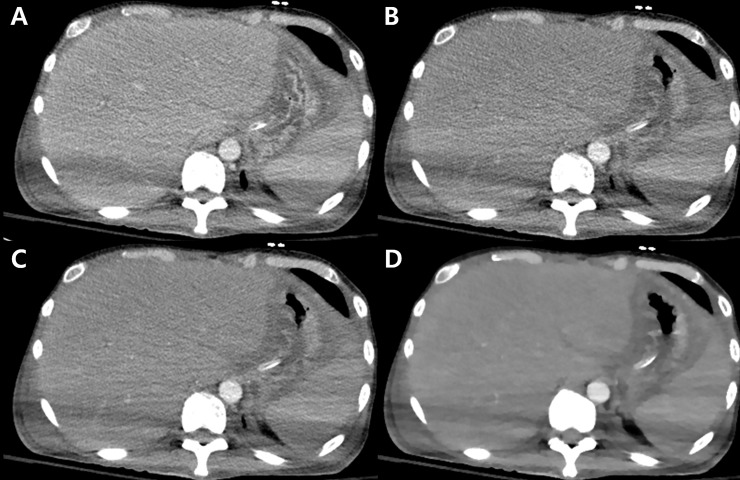
Multidetector CT images (A: standard-dose CT image; B-D: reduced-dose CT images) of a 45-year-old male patient with his two arms positioned on his sides. The section thickness was 3 mm. The window width and level was fixed at 350 and 50, respectively throughout the reconstructed image set. (A) The standard-dose CT image with filtered back projection (FBP) reconstruction shows the presence of beam hardening artifacts associated with the arms-down position. (B) The reduced-dose CT image with FBP reconstruction shows more prominent hypodense and hyperdense artifacts in the liver and spleen compared with (A). (C) A reduced-dose CT image with hybrid iterative reconstruction (iDose level 4) had similar or slightly less beam hardening artifacts than (A) while image quality was preserved. (D) A reduced-dose CT image with iterative model reconstruction (IMR level 3) shows less beam hardening artifacts than (A-C). However, IMR negatively affected the overall image quality due to prominent artificial texture and poor margin sharpness.